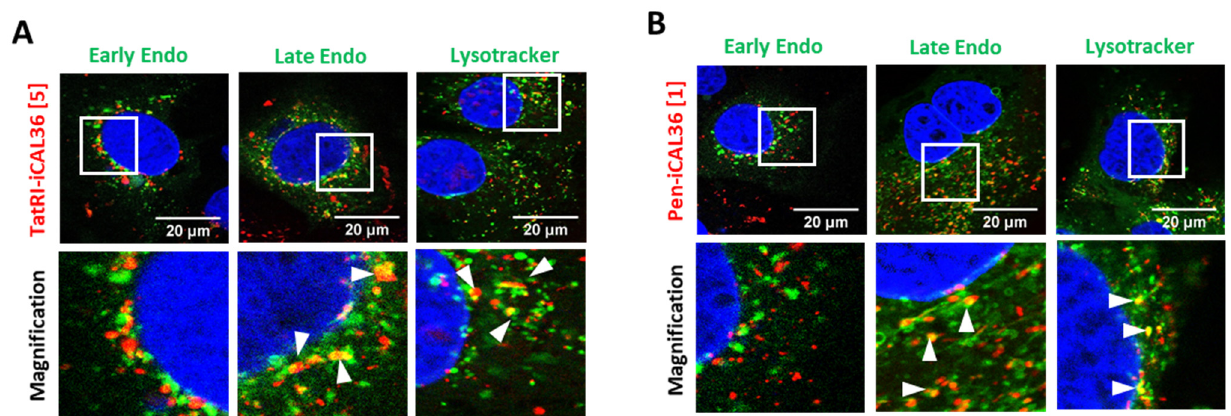
Figure 4. Dissecting vesicular entrapment of TatRI-iCAL36 and Pen-iCAL36. Caco-2 cells were incubated with Tamra-TatRI-iCAL36 (5 μ M = [5] ( A )) and Tamra-Pen-iCAL36 (1 μ M = [1] ( B )) in the presence of vesicle markers such as early and late endosomes, as well as lysosomes. Here, 10 min before the end of the incubation, Hoechst dye (blue = nuclei) and WGA-Alexa488 (green = cell membrane) were added. Cells were washed and covered with DMEM FluoroBrite before imaging. White bars represent 20 μ m.